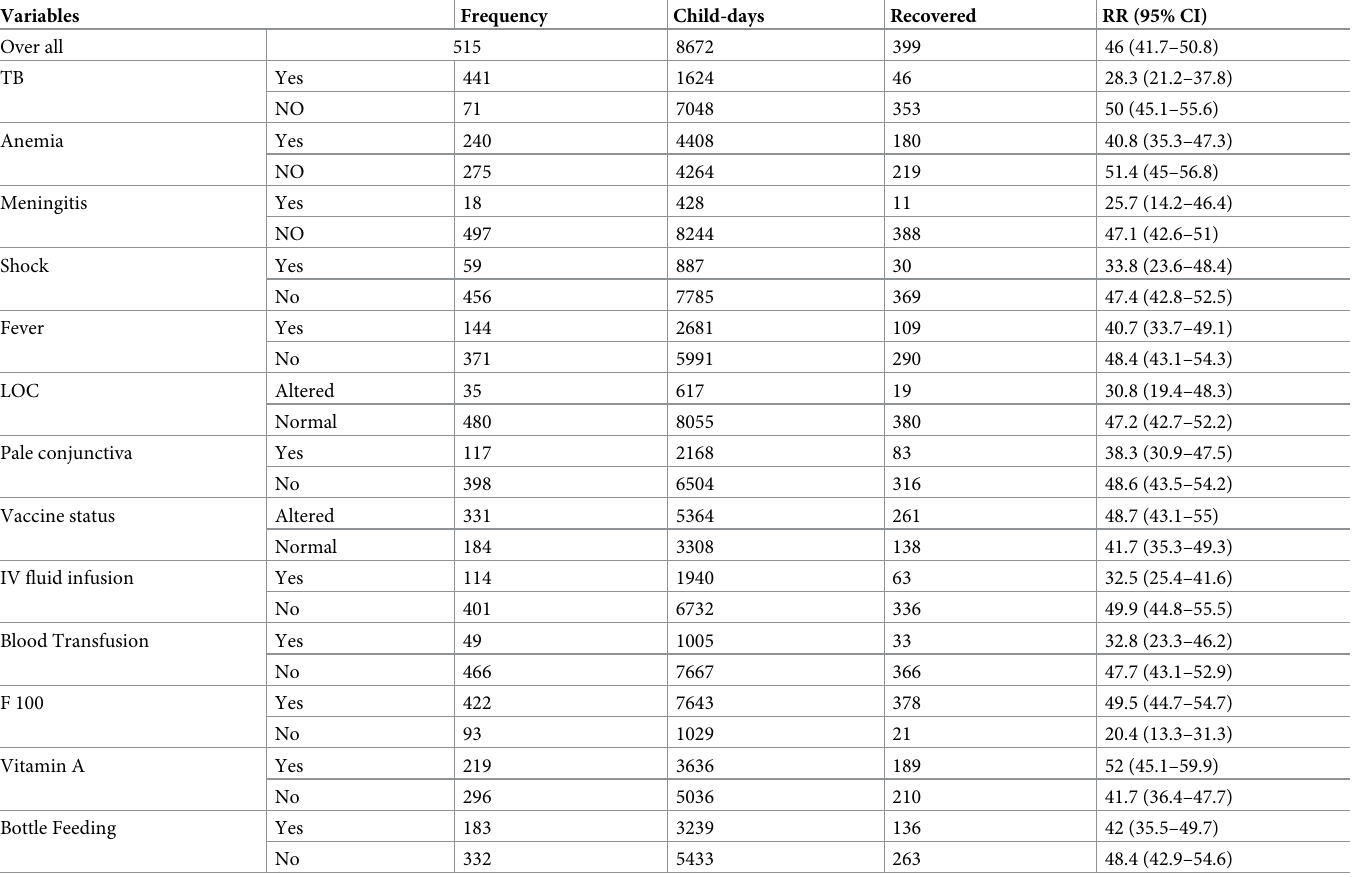
Table 3. Incidence density rate of recovery stratified by selected variables among severely malnourished under five children admitted to SC in SPHMMC, 2012– 2019 (n =